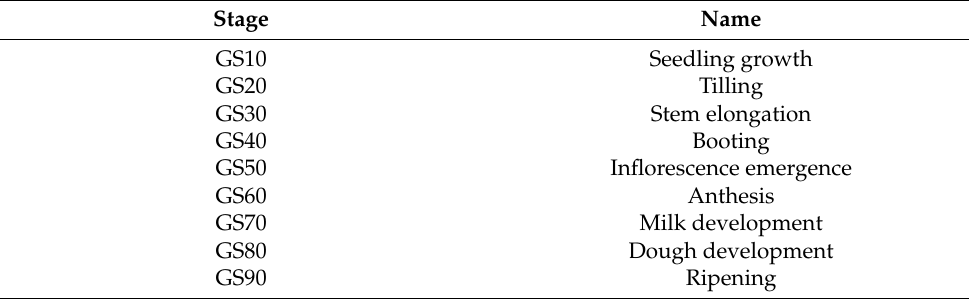
Table 1. Wheat developmental